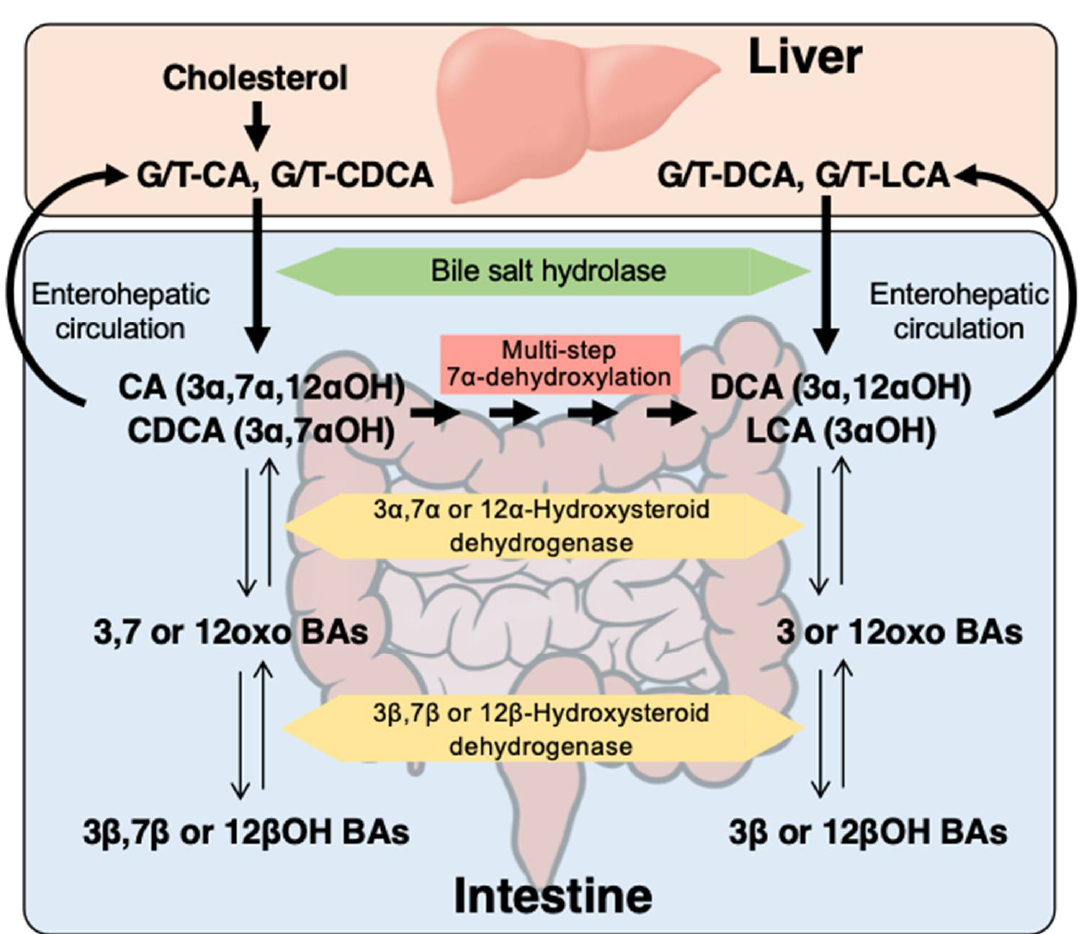
Figure 1. Metabolism of primary bile acids (BAs) conjugated with amino acid (glycine or taurine). Microbial bile salt hydrolase deconjugates the amino acid to form free cholic acid (CA) and chenodeoxycholic acid (CDCA). The free (deconjugated) CA and CDCA are then metabolized to deoxycholic acid (DCA) and lithocholic acid (LCA), respectively by multi-step 7α-dehydroxylation. Hydroxyl groups at the 3α, 7α, and 12α positions can be converted to carbonyl groups by 3α-, 7α-, and 12α-hydroxysteroid dehydrogenases, respectively. In addition, the carbonyl groups at the 3, 7, and 12 positions can be converted to hydroxyl groups at the 3β, 7β, and 12β positions by the reverse reactions of 3β-, 7β-, and 12β-hydroxysteroid dehydrogenases, respectively. G/T-, glycine or taurine conjugated.